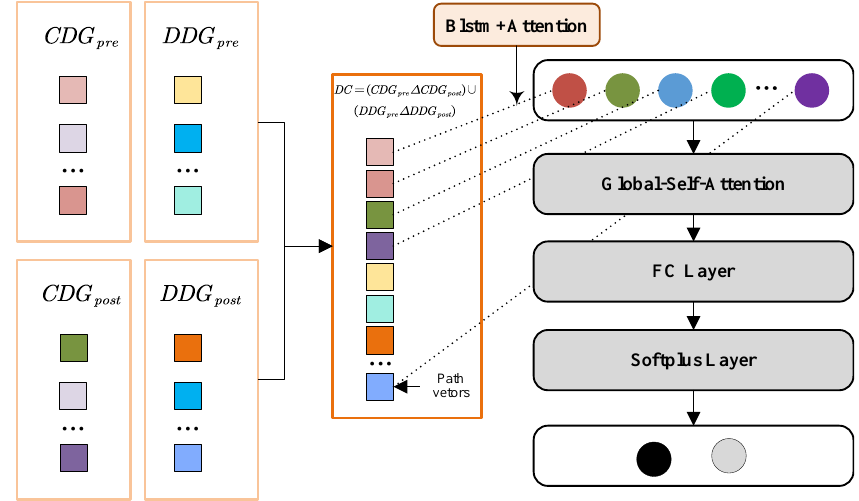
Figure 2. The neural network structure for evidence obtained from the code diff view.